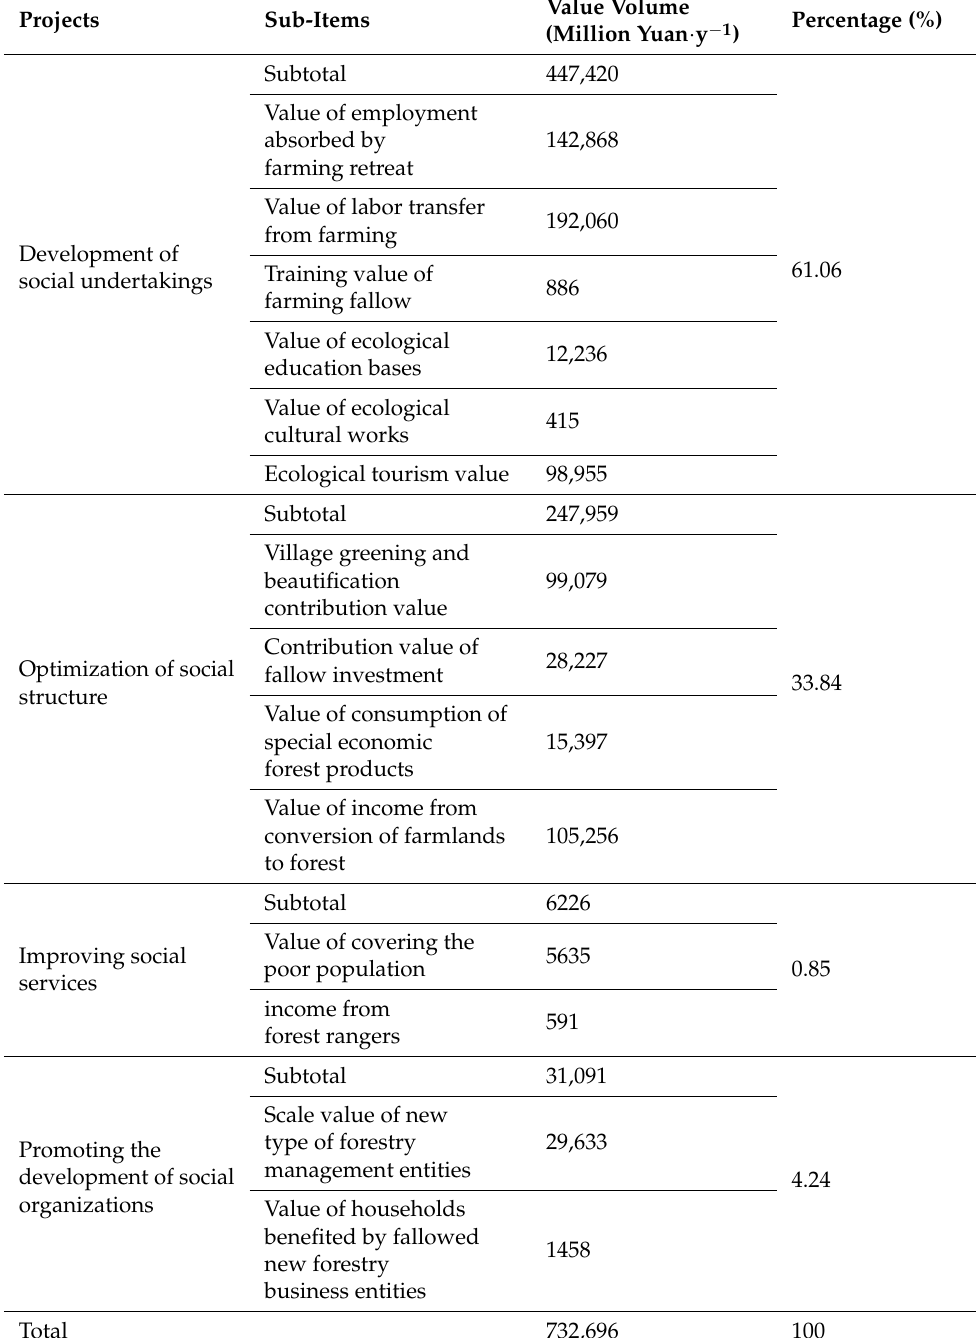
Table 6. Social value of the CFFG project in